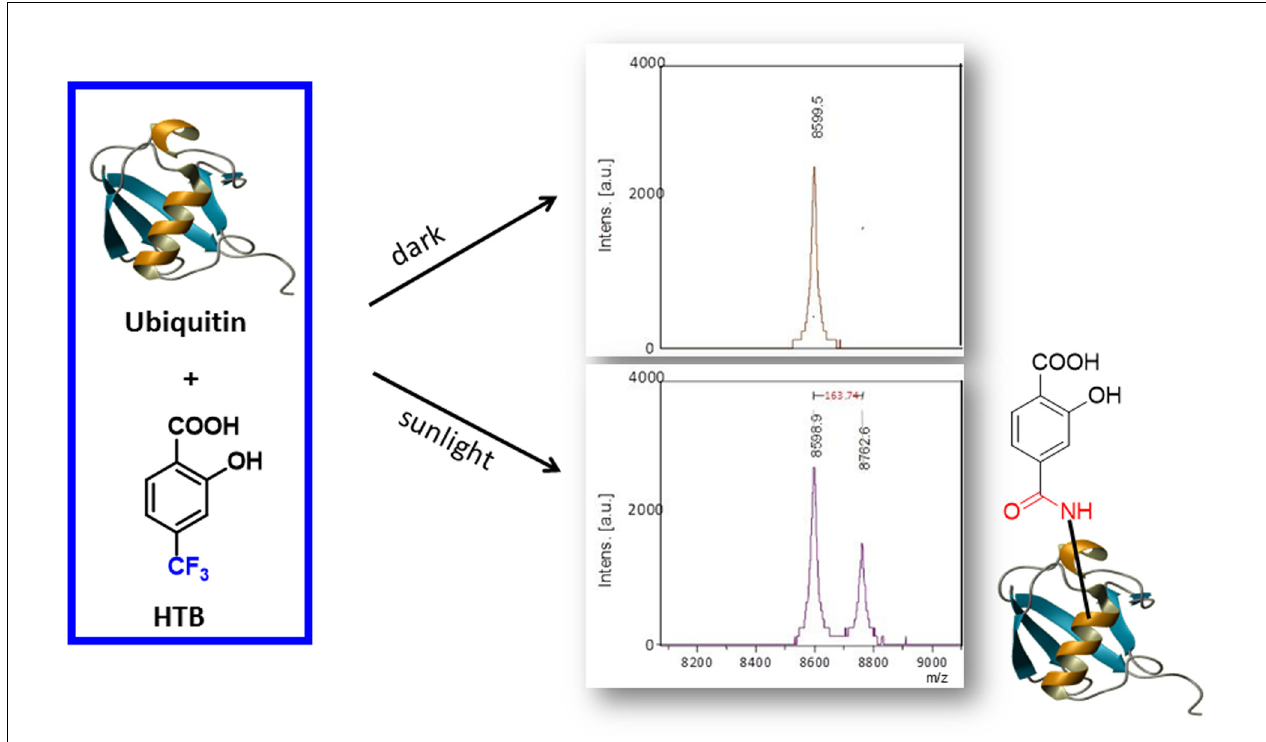
FIGURE 6 | MALDI-TOF spectra of HTB-ubiquitin (10:1) kept in the dark (Top) or solution after 30 min of sunlight irradiation (Bottom). TABLE 1 | Identification of HTB-modified peptide by MS/MS spectrometry. Peptide adduct